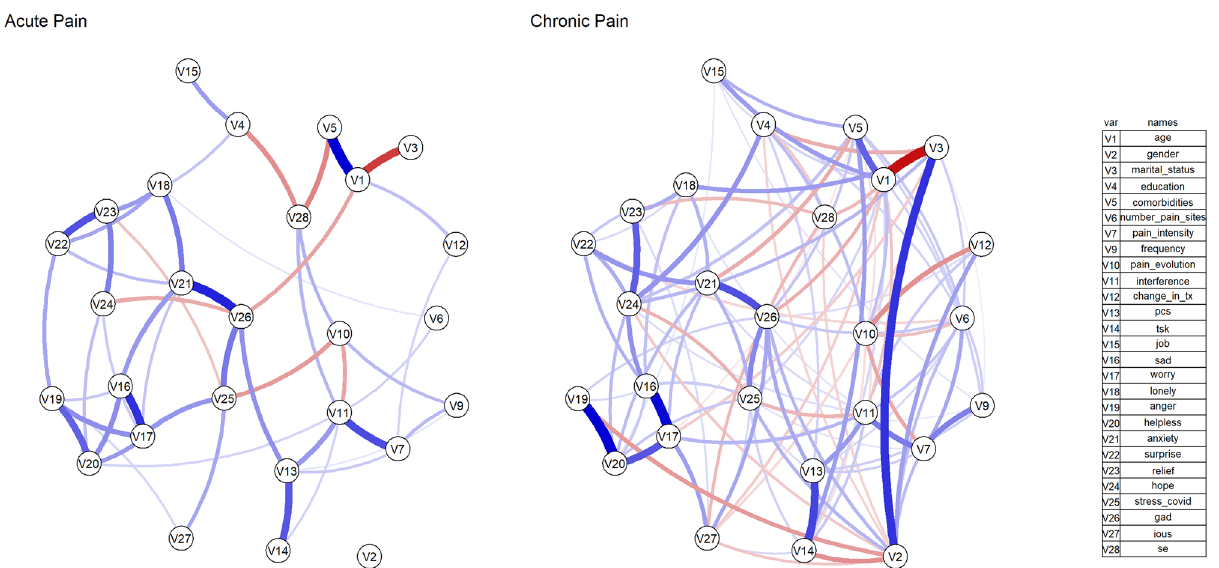
Figure 4. Subgroup network analysis for differences in pain chronicity. Edges represent connections between two nodes and are interpreted as the existence of an association between two nodes, adjusted for all other nodes. Each edge in the network represents either positive regularized adjusted associations (blue edges) or negative regularized adjusted associations (red edges). The thickness and colour saturation of an edge denotes its weight (the strength of the association between two